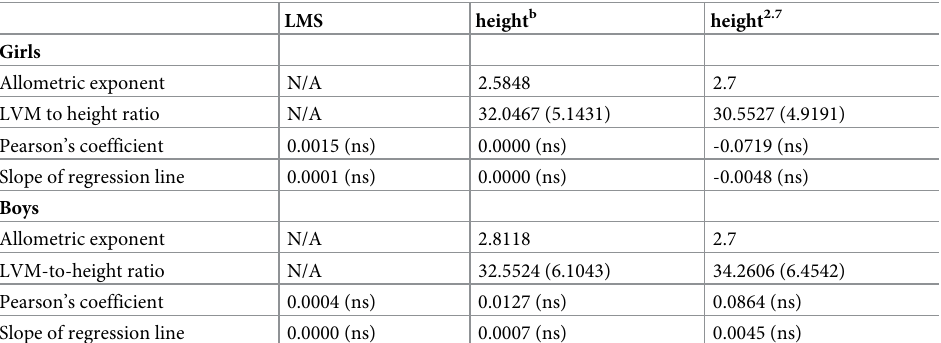
Table 2. The LVM normative data for allometrically adjusted LVM-to-height ratios and the parameters used to assess the relationship between the normalized LVM and height for the LMS method and both variants of the allo- metric